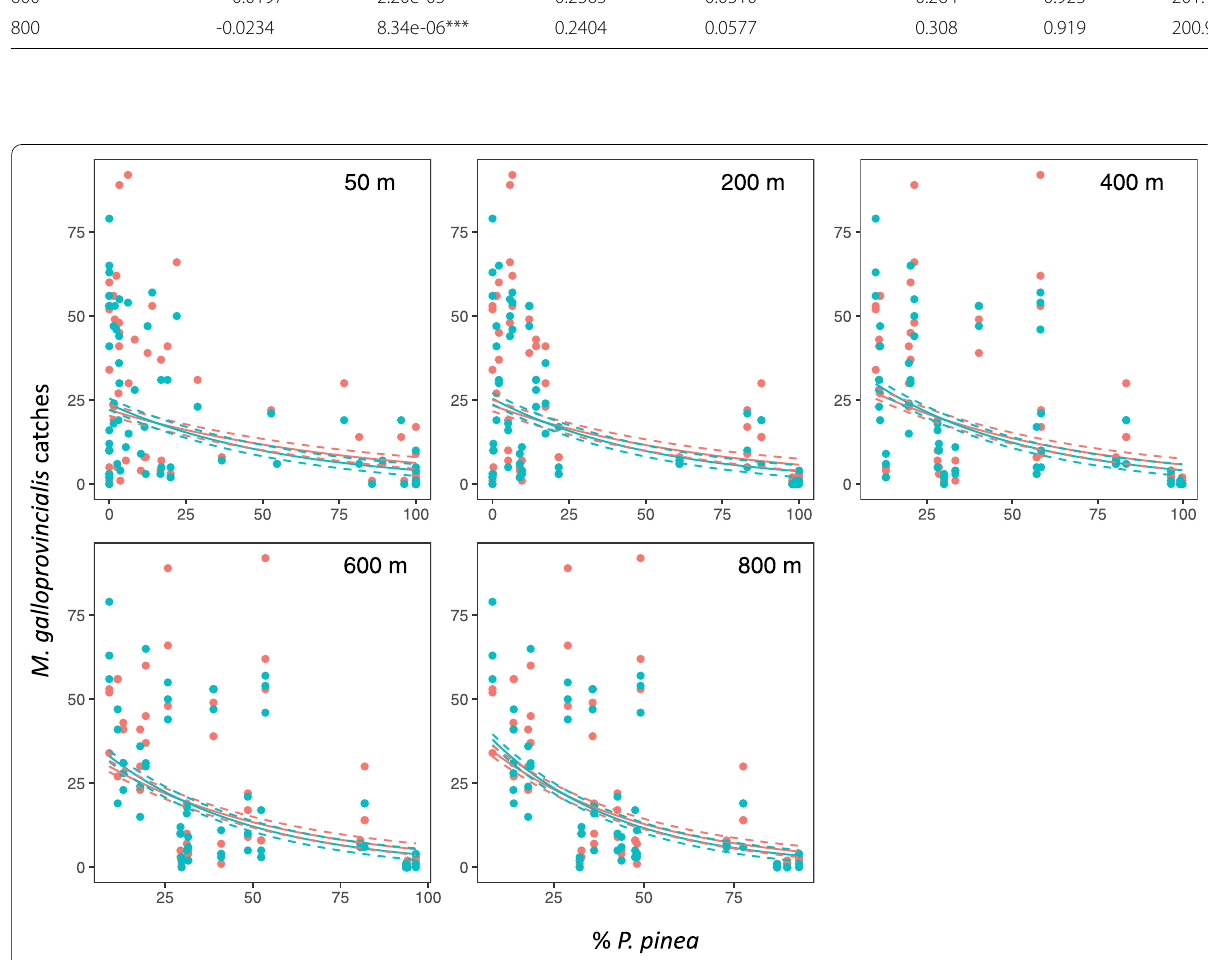
Fig. 2 Effect of the % P. pinea in buffers of increasing radii (50 m, 200 m, 400 m, 600 m, and 800 m) on captures of males and females of M. galloprovincialis per trap. Lines correspond to model predictions (solid line) and their standard error (dashed